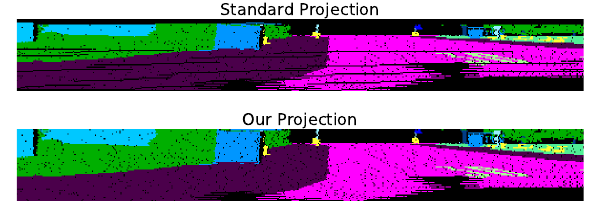
Figure 2. SV projection: two cropped images showing difference between the standard projection, and our